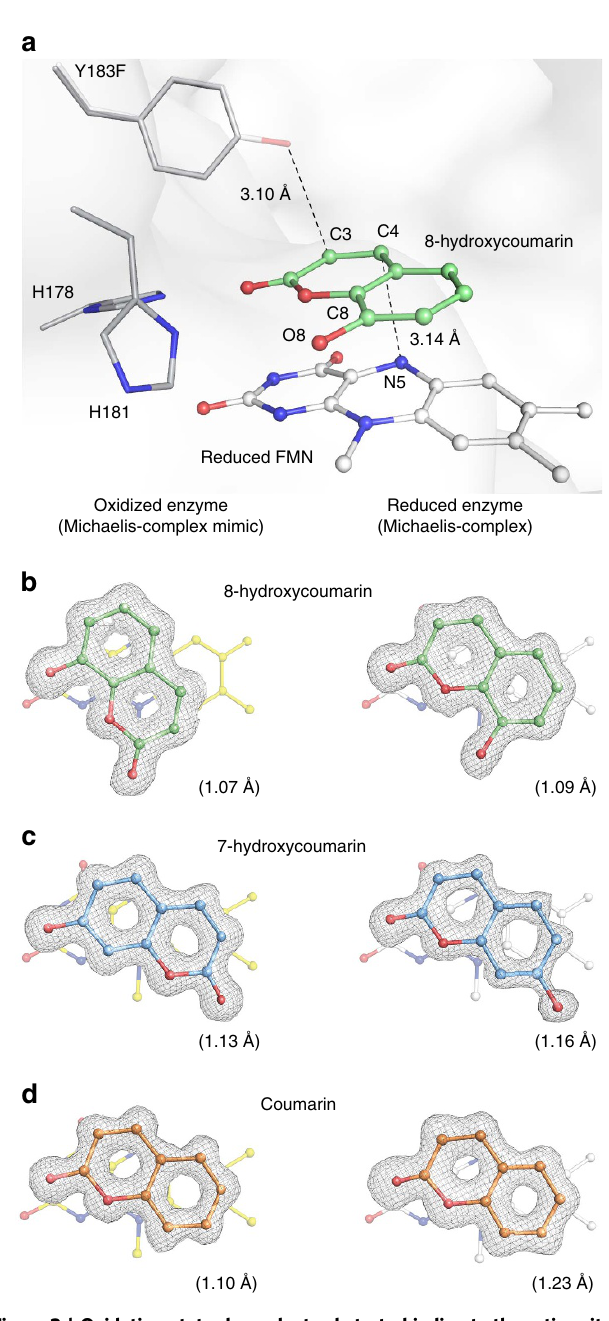
Figure 3 | Oxidation-state-dependent substrate-binding to the active site of XenA. ( a ) Active site view of the Michaelis complex between reduced Y183F-XenA and 8-hydroxycoumarin (green sticks). The Y183 hydroxyl group of wt-XenA is depicted semitransparent. The dashed lines illustrate the distances between the a , b -carbon double bond of the substrate with either the N5 atom of the isoalloxazine ring or the oxygen atom of the Y183F hydroxyl group. ( b , c ) View on the si -face of FMN illustrates the different orientations that 8-hydroxycoumarin ( b ) and 7-hydroxycoumarin ( c ) adopt in the oxidized and reduced enzyme. ( d ) The hydroxyl group lacking substrate coumarin (orange carbons) binds in the same orientation regardless of the oxidation state of the cofactor. The F o– F c omit maps of the substrate molecules are contoured at 4.0 s . The values in parenthesis give the resolution of the diffraction data used for refinement ( d min ).